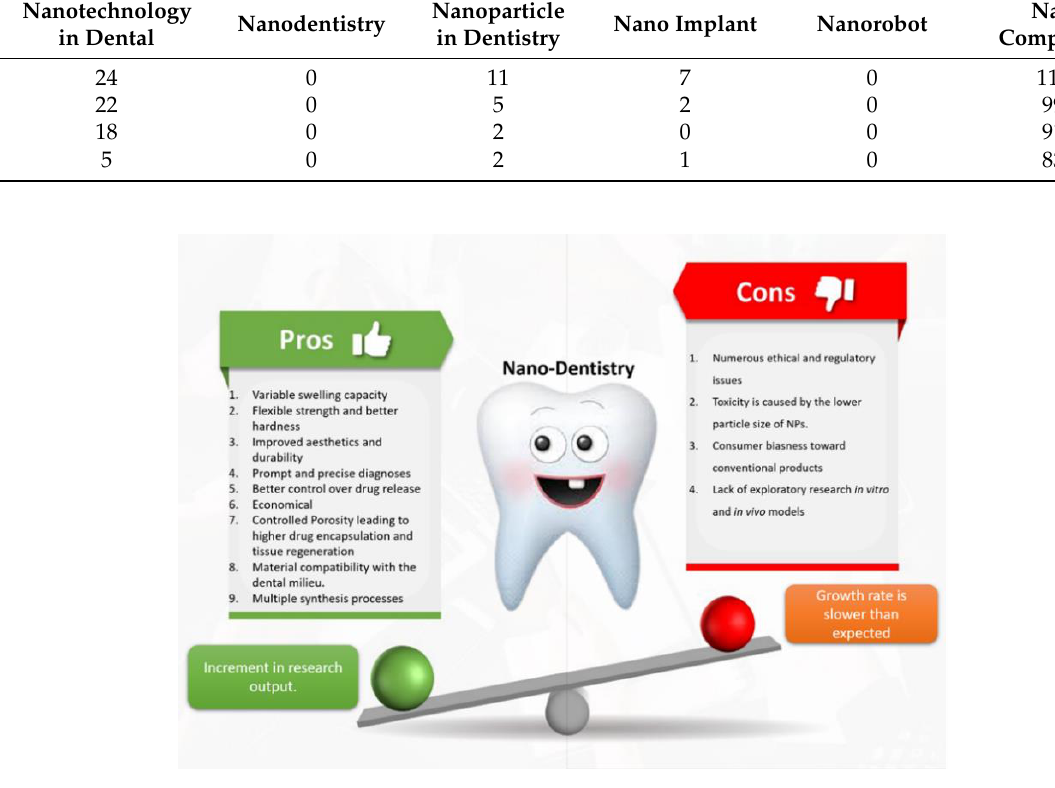
Figure 2. Various synthesis approaches implemented in nanodentistry.